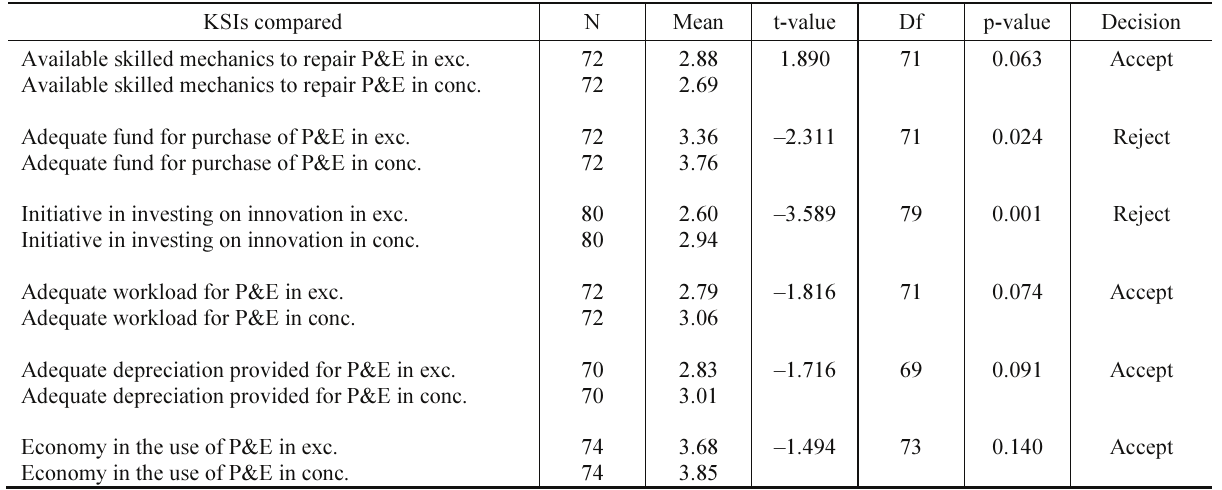
Table 8. Result of t-test for difference in the level of sustainability of mechanisation between excavation and concrete operations KSIs compared N Mean t-value Df p-value